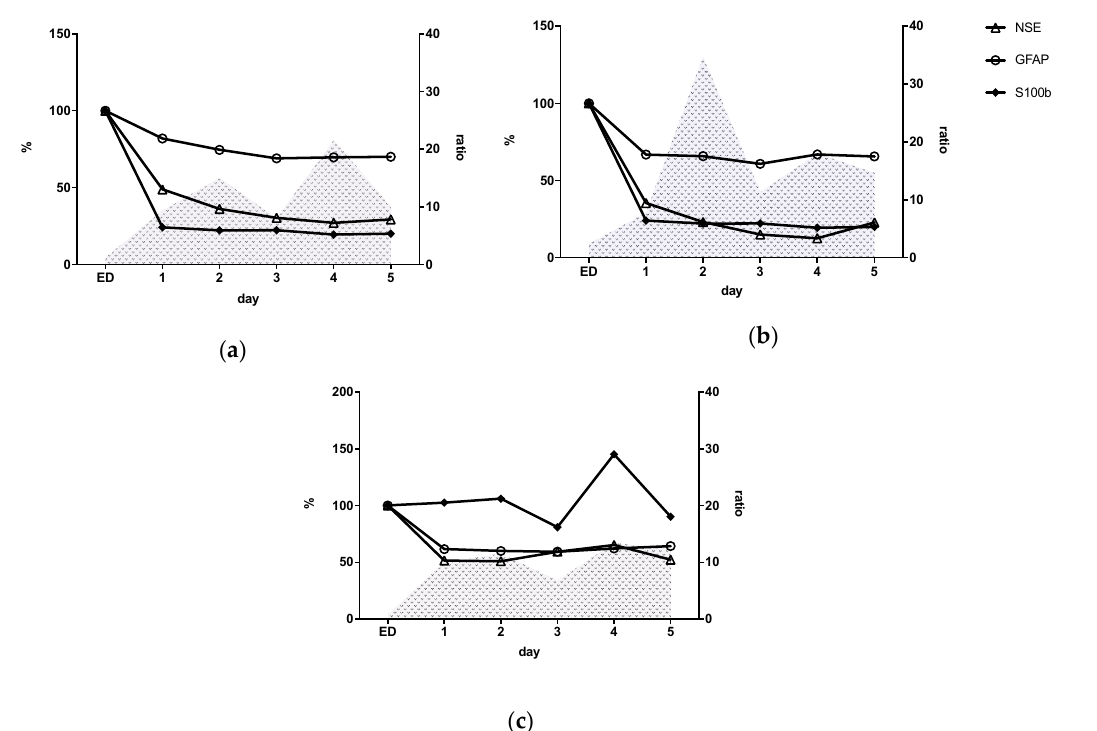
Figure 3. Pro-inflammatory response (Interleukin (IL)-6 / Interleukin (IL)-10 ratio, grey-hatched) and neuronal marker expression (Neuron-specific enolase 2 (NSE), glial fibrillary acidic protein (GFAP), calcium-binding Protein B (S100b)) after ( a ) polytrauma (PT); ( b ) polytrauma + traumatic brain injury (TBI); ( c ) isolated TBI (isTBI). ED = Admission to Emergency Department.